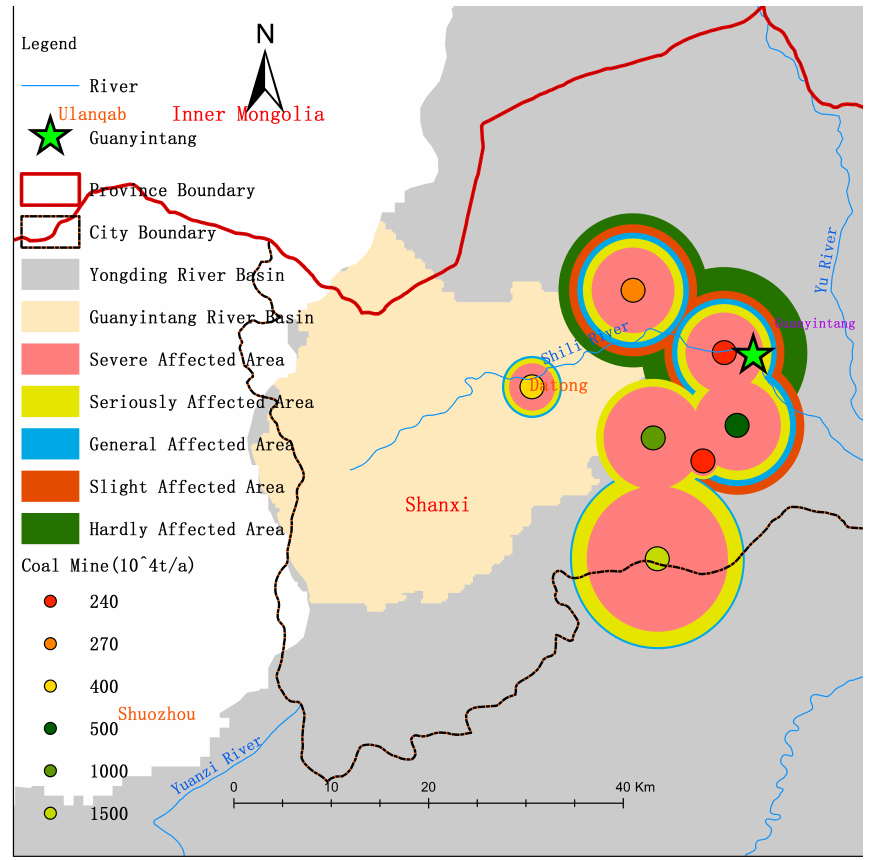
Figure 6. Geographical locations of the coal mines in the Guanyintang River basin and the scope of areas affected by coal